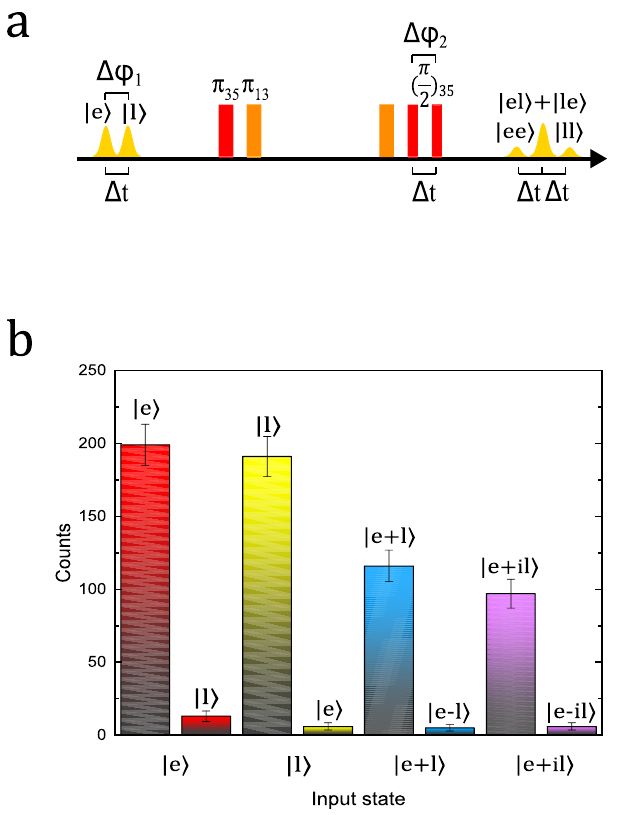
Fig. 4 Time-bin qubits fi delity measurement. a The pulse sequence for the preparation and analysis of time-bin qubits. The time difference between e j i and l j i is Δ t, and the relative phase is controlled as Δ φ 1 . After three π pulses Þ that are the same as that required in standard NLPE, two ð π are employed 2 35 Þ to read out each input twice. The time difference between two ð π is also 2 35 Δ t, and the relative phase is controlled as Δ φ 2 . b Storage performances for four input qubit states. The average photon number per qubit is 2.29 photons. For input states e j i and l j i , the output is projected on e j i and l j i . For input superposition states ( e j i þ l j i and e j i þ i l j i ), the output is projected superposition states, which generate the maximal interference and minimal interference results in the middle output bin. Photon-counting histograms can be found in Supplementary Fig. 2 and the experiments are repeated for 20,000 trials. The error bars represent one standard deviation of photon counts assuming Poissonian photon time bin and the late time bin, respectively. e j i and l j i are sepa- rated by a delay of Δ t and the relative phase is controlled to be Δ φ 1 . The memory performance is assessed by four different input